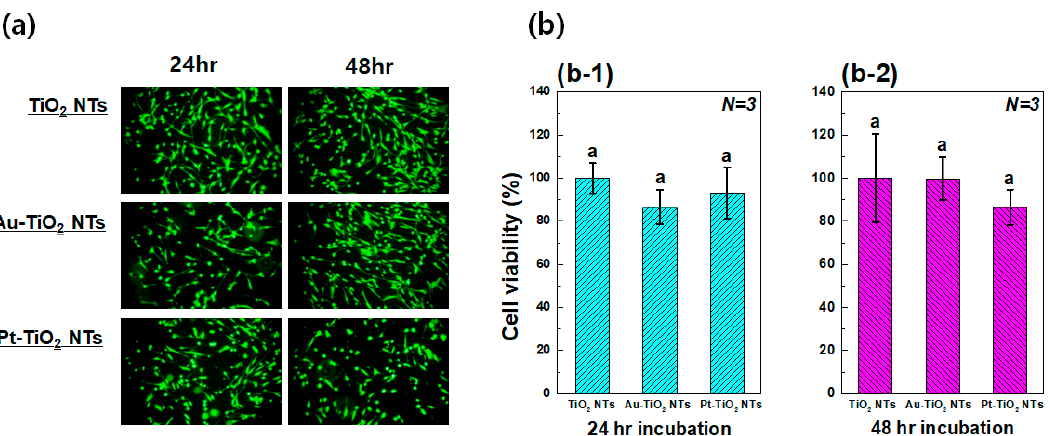
Figure 6. ( a ) Calcein AM and EthD-1 stained images and ( b ) MTT assay results of Human mesenchymal stem cells (hMSCs) cultured on TiO 2 NTs, Au–TiO 2 NTs and Pt–TiO 2 NTs after ( b-1 ) 24 h and ( b-2 ) 48 h incubation (in each graph, entries with the same lowercase letters were not significantly different as determined by one-way ANOVA at α = 0.05).